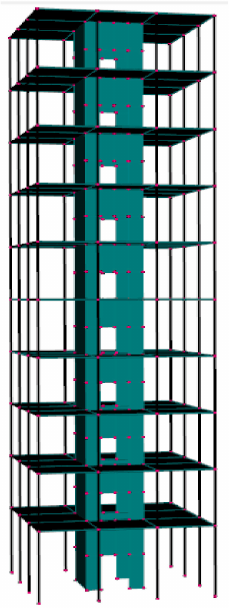
Figure 9. The finite element (FE) model.